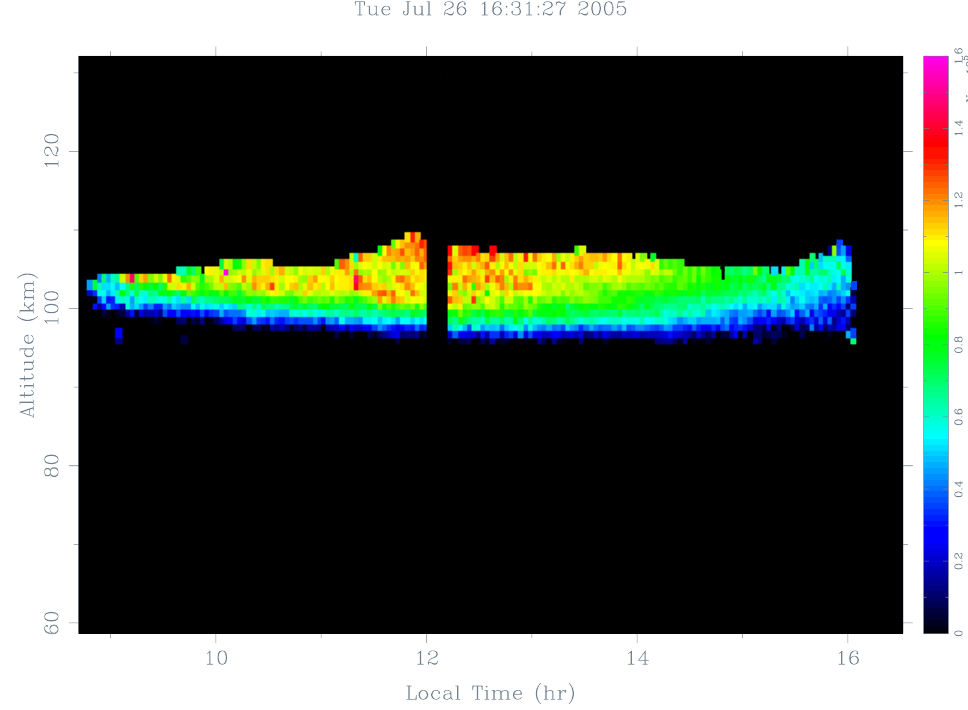
Fig. 2. Electron density measured by radar (color